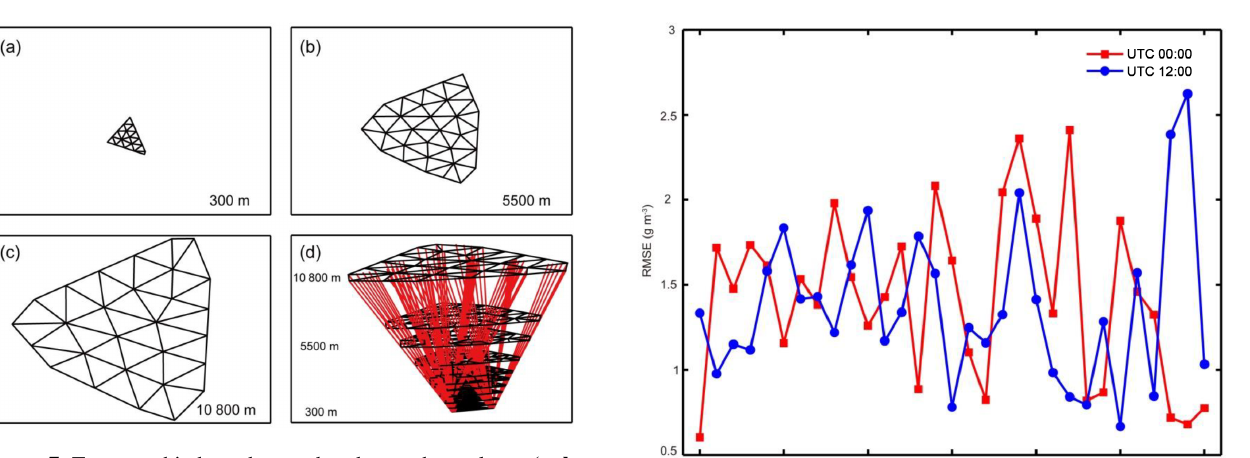
Figure 7. Tomographic boundary and nodes on three planes (a, b, c) and the tomographic field and nodes (d) at tomographic epoch 00:00UTC on DOY 121, 2015. Figure 8. RMSE of model-derived water vapor density values at